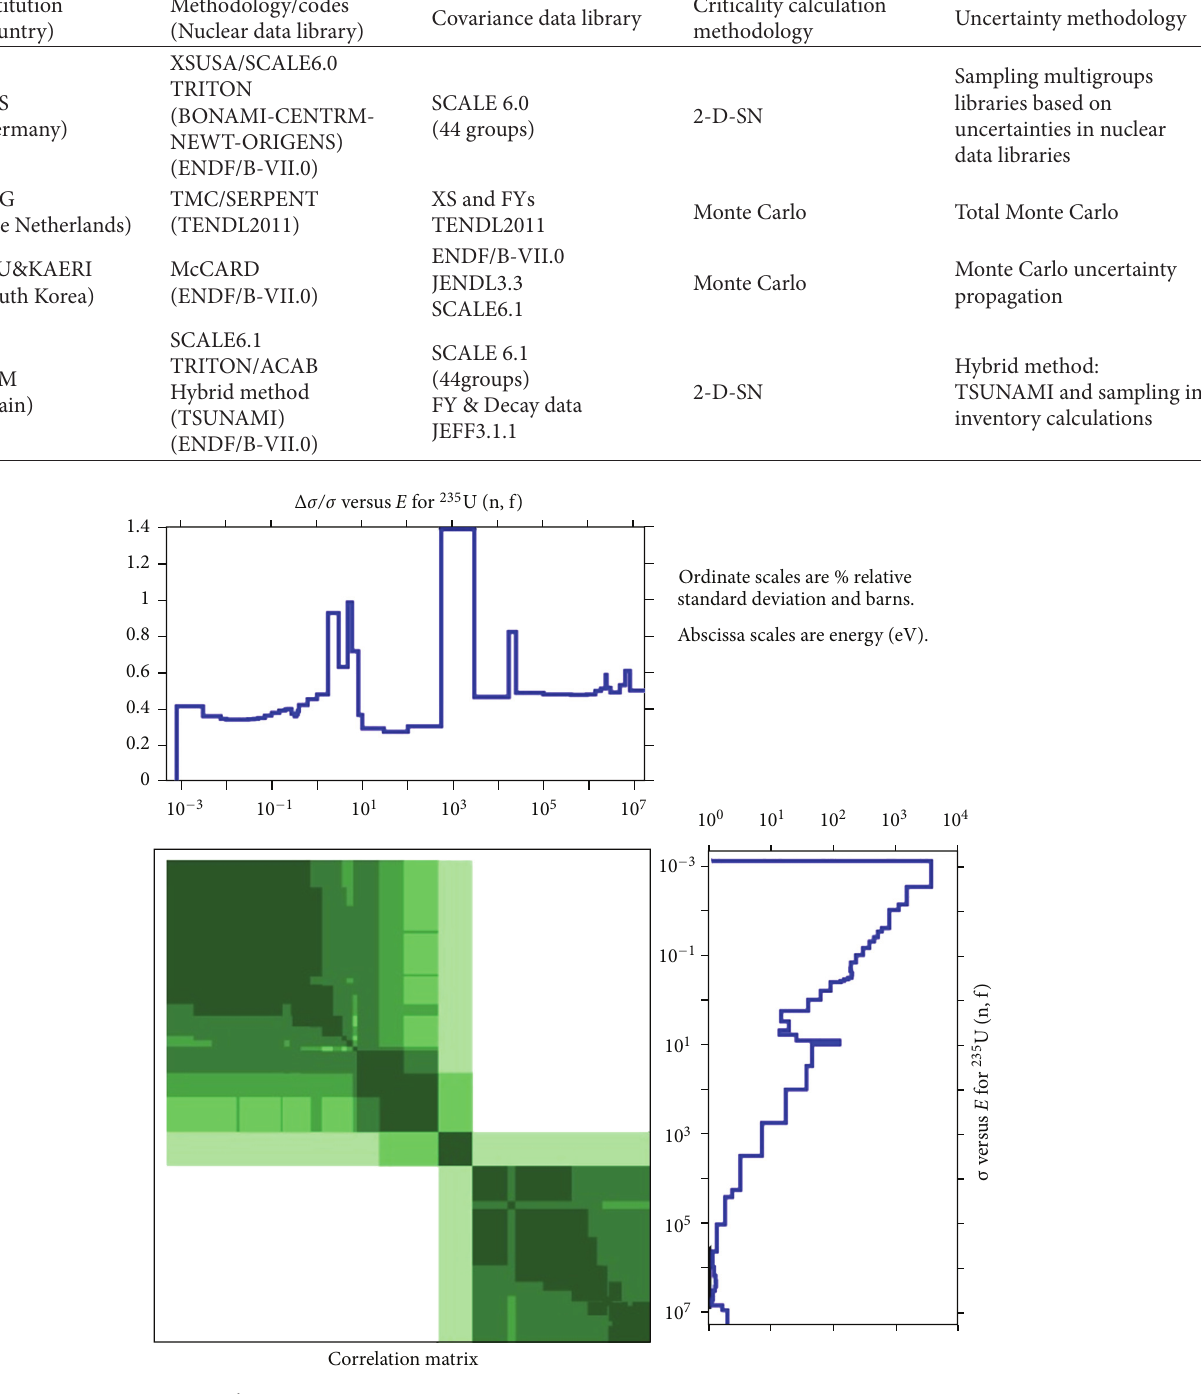
T 4: List of participants and brief description of their methodologies used in this benchmark.